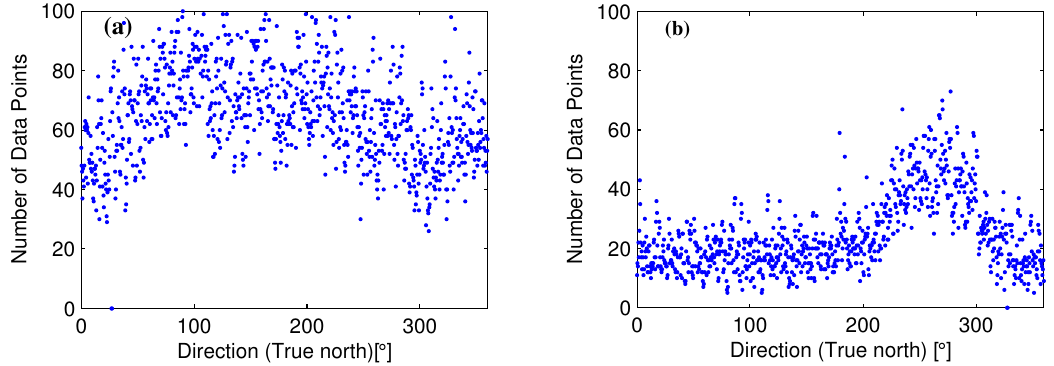
Figure 2. Number of pixels with intensity higher than the threshold for each direction of the ( a ) texture map in Figure 1c; ( b ) texture map in Figure